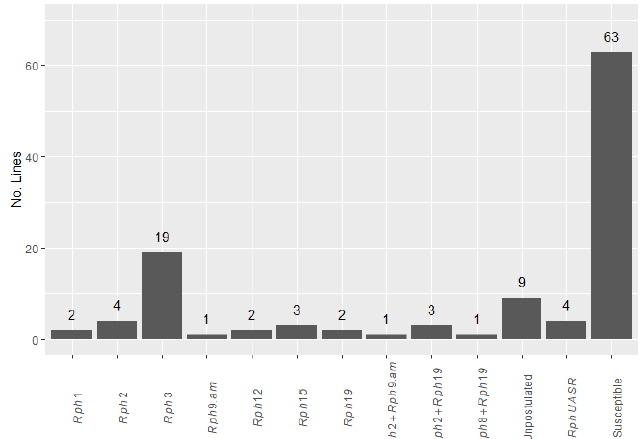
Figure 1. Frequency distribution of known and unknown Rph genes postulated in 114 CAIGE